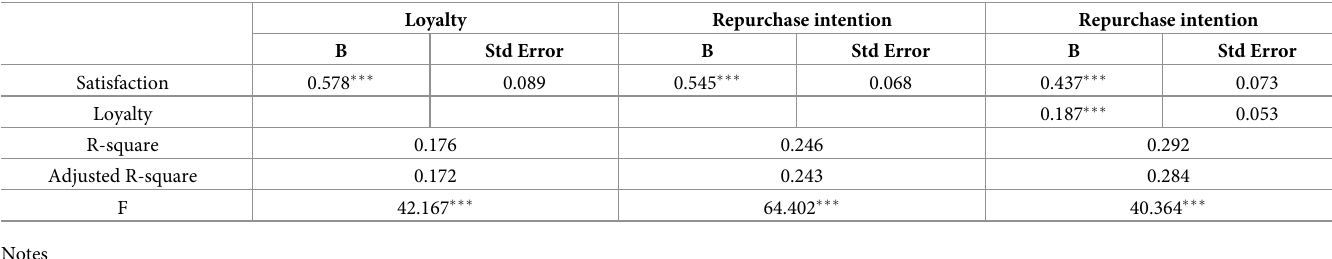
Table 8. Results of the regression analysis on customer loyalty, satisfaction and repurchase